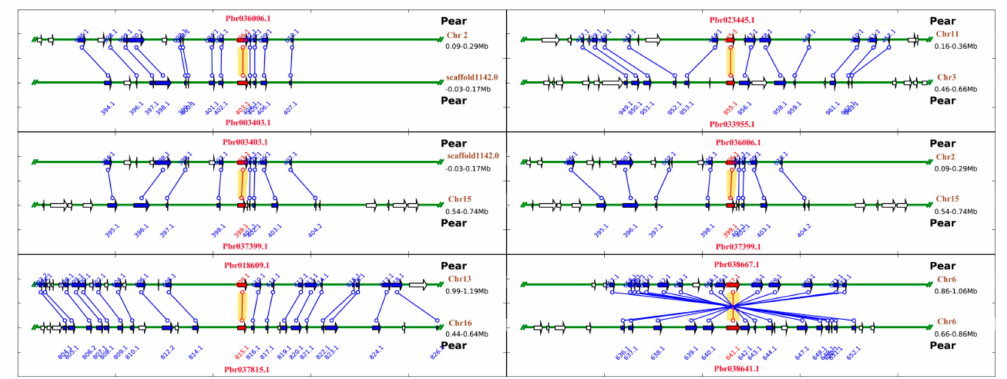
Figure 5. Microsynteny maps of PbRBOH s and their flanking genes within syntenic chromosomal intervals. The relative positions of all flanking protein-coding genes were defined by the anchored RBOH s, highlighted in red. The chromosome segments are shown as horizontal lines, with arrows corresponding to individual genes and their transcriptional orientations. Conserved gene pairs among the segments are connected with